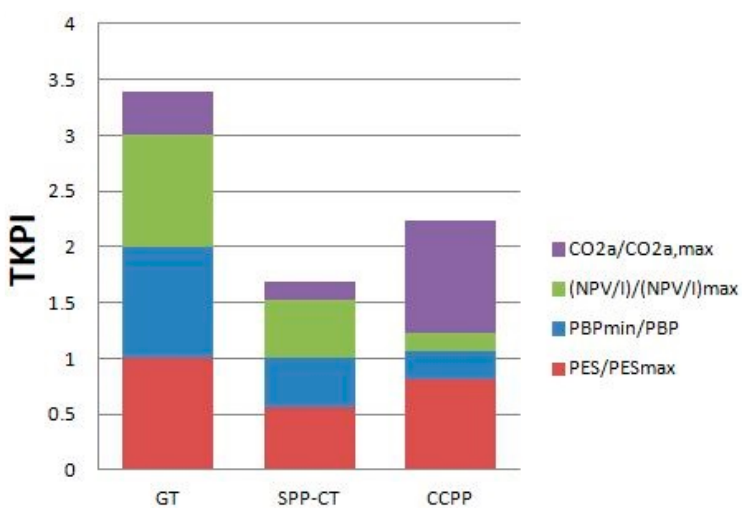
Figure 12. TKPI values and breakdown for the considered cogeneration technologies with white certificates taken into account (alternative design).